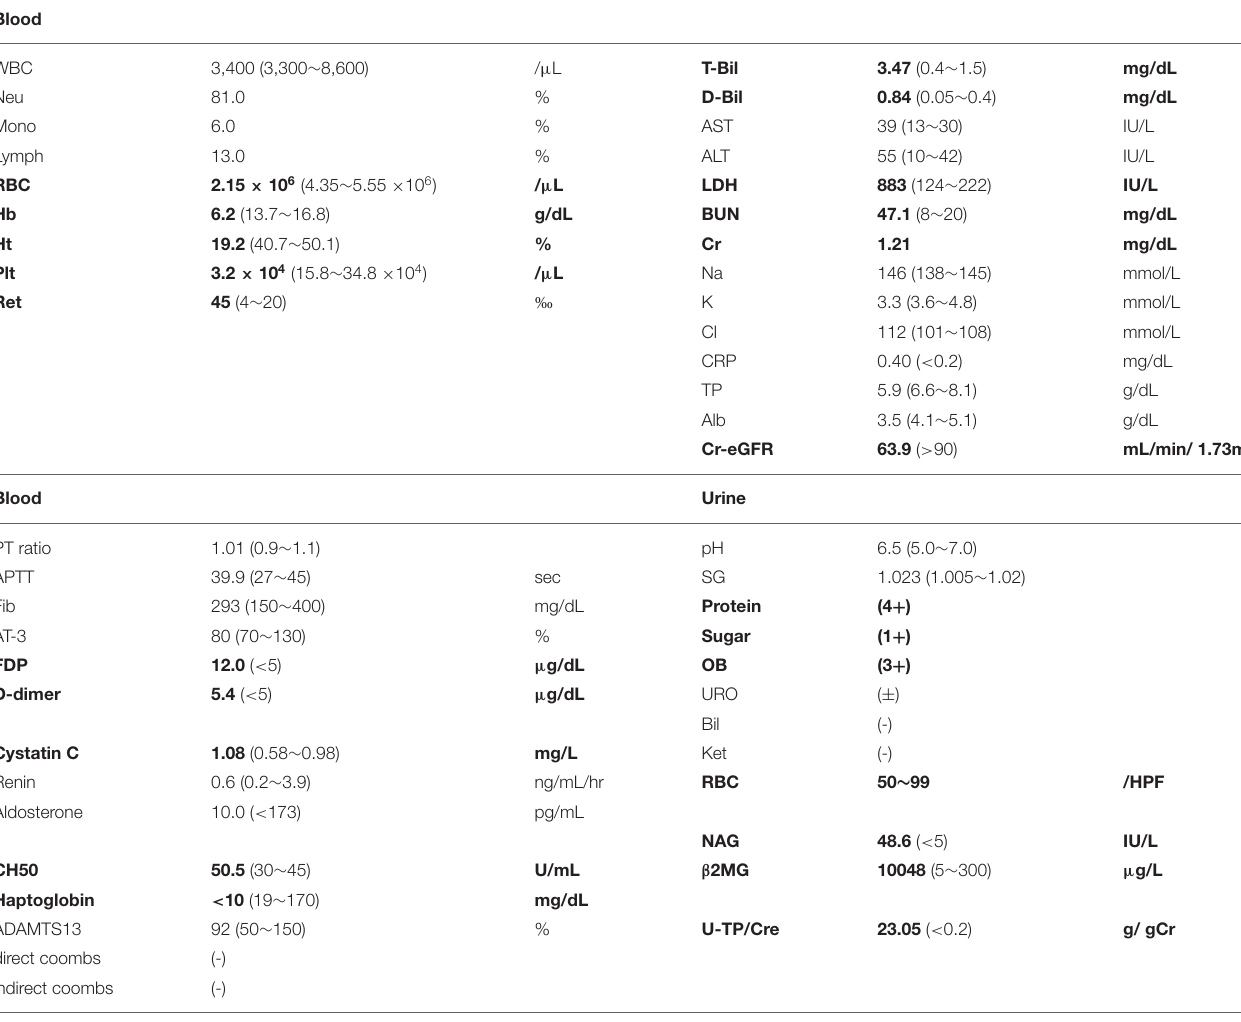
TABLE 1 | Blood and urine test findings at the time of the second pulmonary hemorrhage (Parentheses indicate normal values).